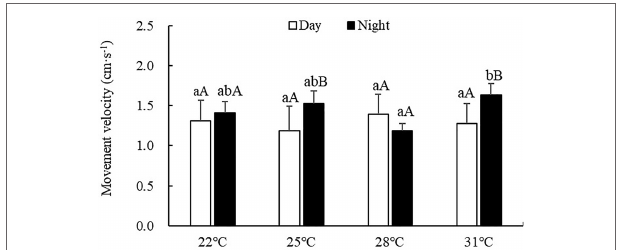
FIGURE 3 | Cumulative motion time of S. monotuberculatus at four temperature conditions. Marks of lowercase letters indicate that there is a significant difference at different temperatures ( P <0.05); marks of uppercase letters indicate that there is a significant difference between day and night ( P <0.05).